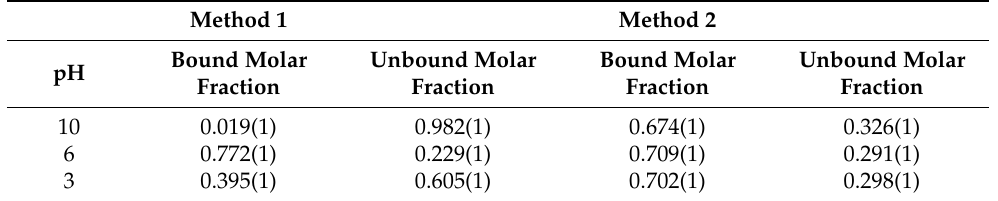
Table 5. Molar fraction of 99m Tc amount bound/unbound to MAA depending on pH values (Mean (SD)).